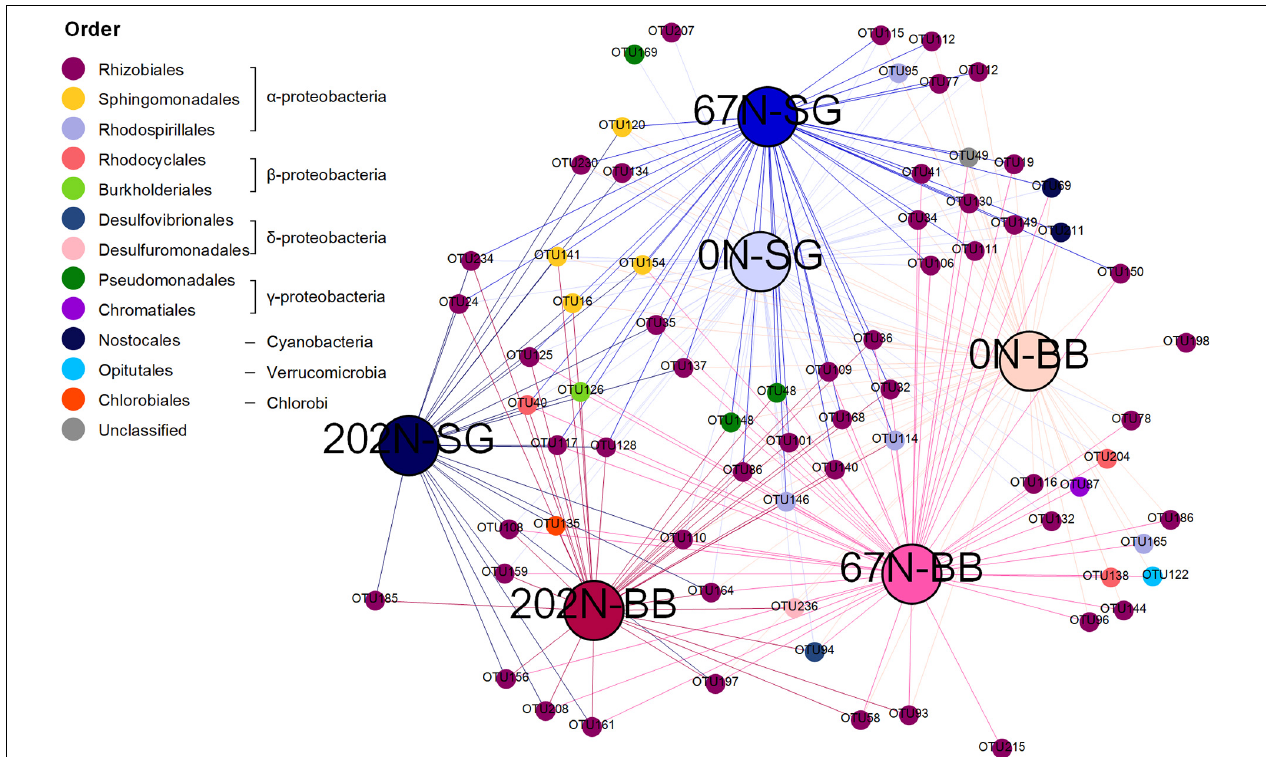
FIGURE 6 | Association network showing significant ( p < 0.05) positive associations between nifH OTUs and specific habitat under two different treatments [specific N fertilization rate (0N, no N fertilization; 67N, 67 kg N ha − 1 fertilization; 202N, 202 kg N ha − 1 fertilization) and grass species (SG, switchgrass; BB, big bluestem)]. Large nodes represent treatments. Small nodes represent nifH OTUs. Line colors reflect treatments. nifH OTUs were grouped to order level.